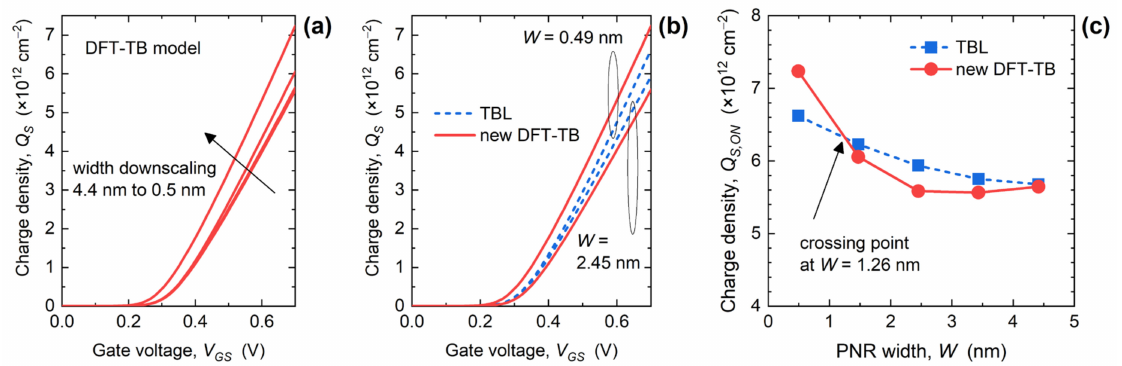
Figure 6. ( a ) Charge density vs. gate bias characteristics in PNR FETs. Comparison of ( b ) Q s - V GS curves for 0.49 nm and 2.45 nm-wide devices, and ( c ) Q s - W characteristics in the ON-state obtained by the two TB